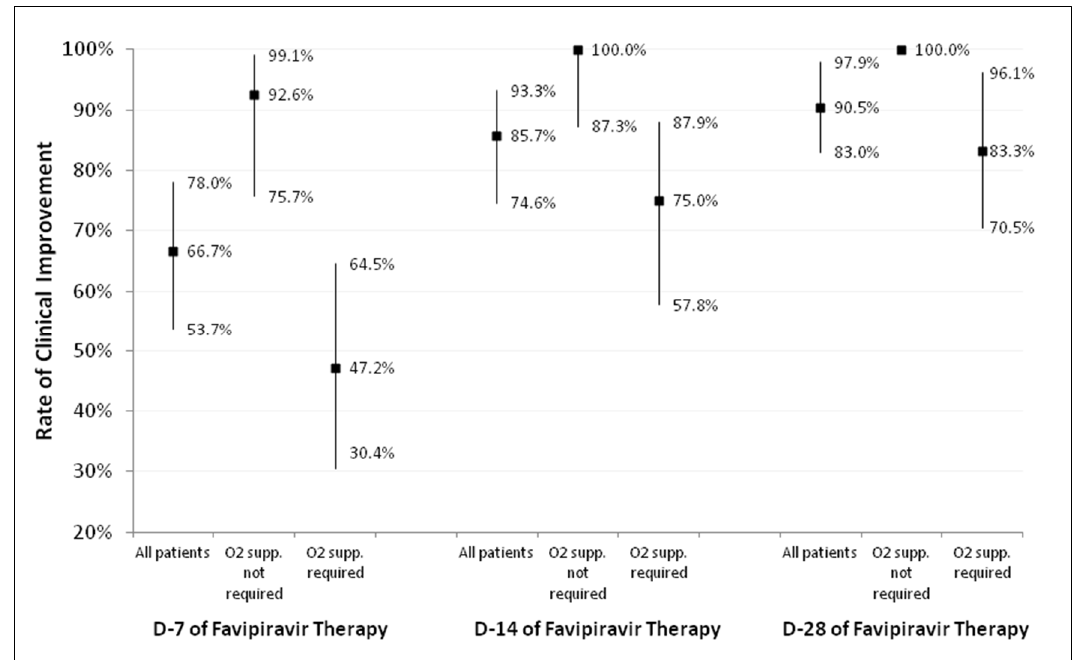
Figure 1. Rate of clinical improvement on Day 7, Day 14, and Day 28 of favipiravir therapy, stratified by the requirement for O 2 supplementation. Table 2. Hospital course and treatment outcomes.